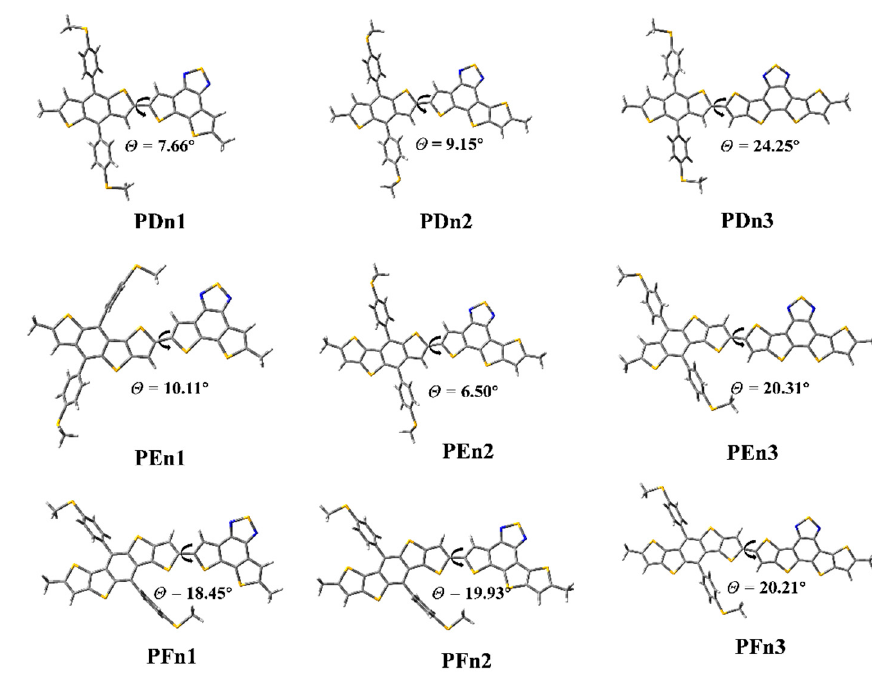
Figure 4. The optimized geometry of the oligomers.